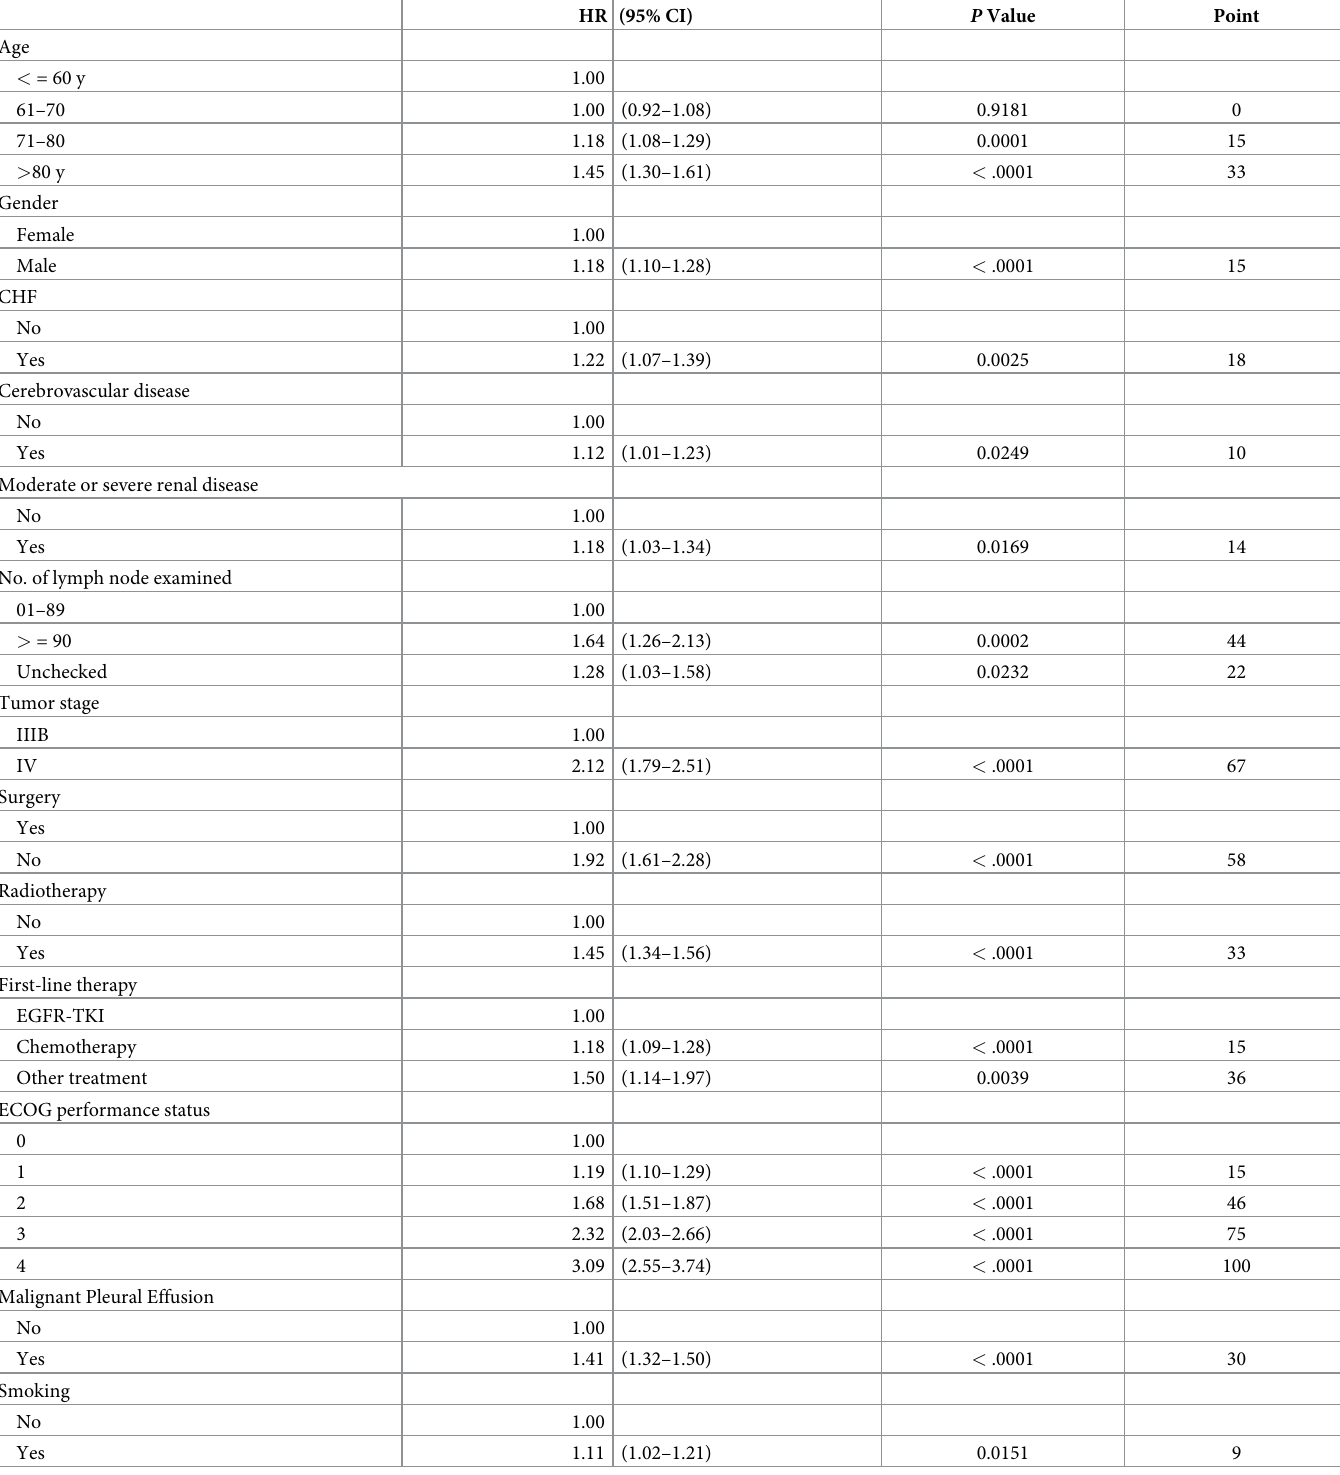
Table 2. Multivariable Cox proportional hazards regression analysis, point assignment and prognostic score: EGFR mutation positive